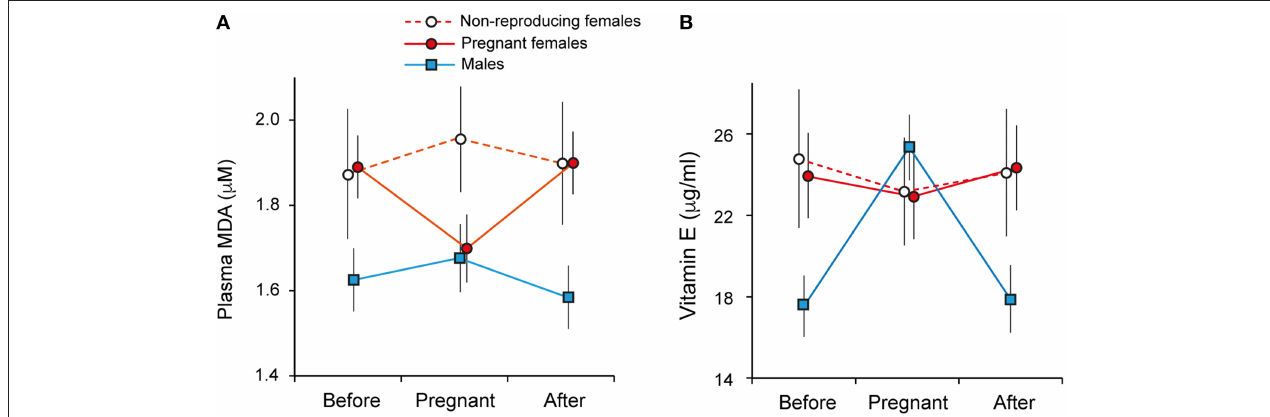
FIGURE 3 | Oxidative damage and reproductive state in banded mongooses. (A) Plasma malondialdehyde (MDA) was lower in females during breeding, and (B) males had higher levels of vitamin E ( α -tocopherol) during group breeding. Data points represent mean ± SE of longitudinally sampled individuals during pregnancy and in a non-pregnant state 3 months pre- and